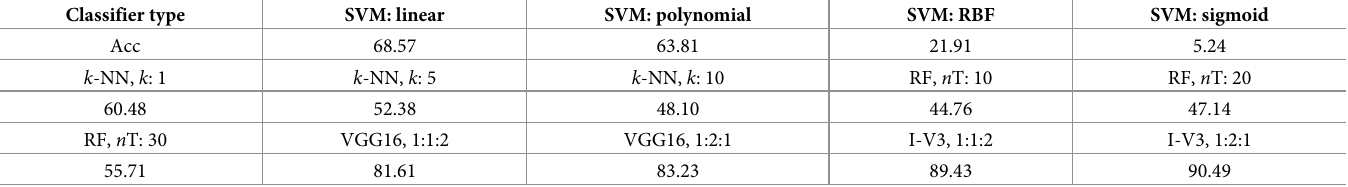
Table 13. A comparison of EM image classification results using EMDS-5. Accuracy (Acc), n Tree ( n T), VGG16 (Train: Validation: Test = 1: 1: 2) is VGG16: 1: 1: 2, VGG16 (Train: Validation: Test = 1: 2: 1) is VGG16: 1: 2: 1, Inception-V3 (Train: Validation: Test = 1: 1: 2) is I-V3: 1: 1: 2, Inception-V3 (Train: Validation: Test = 1: 2: 1)